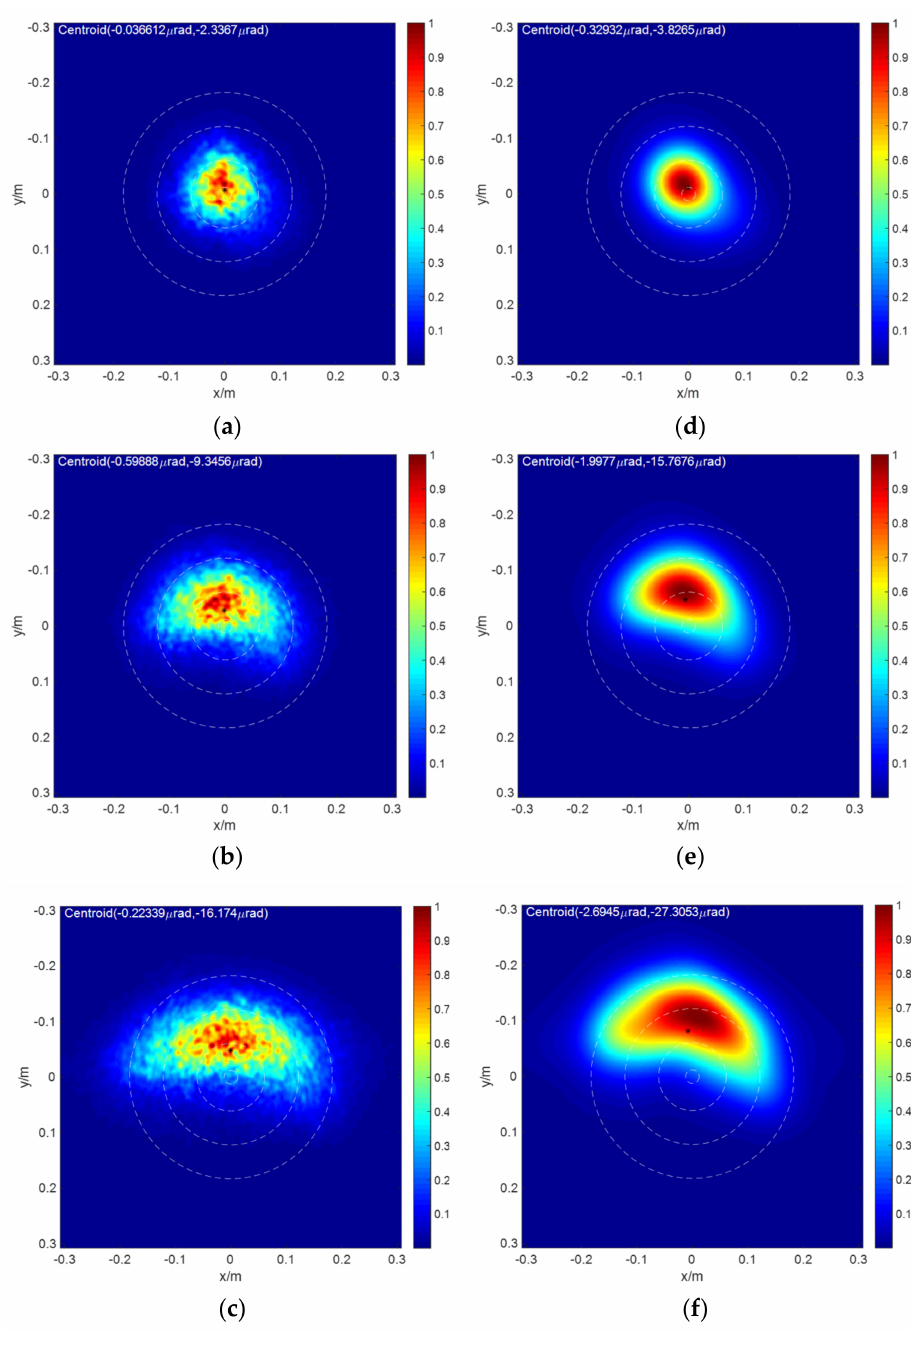
Figure 9. 4D wave optics simulation results ( a – c ) and the far-field intensity distribution for fast calculation results ( d – f ) with S5, S6, and S7 scenario pairs presented top to bottom, respectively. Table 4. Fast calculation with PSF convolution